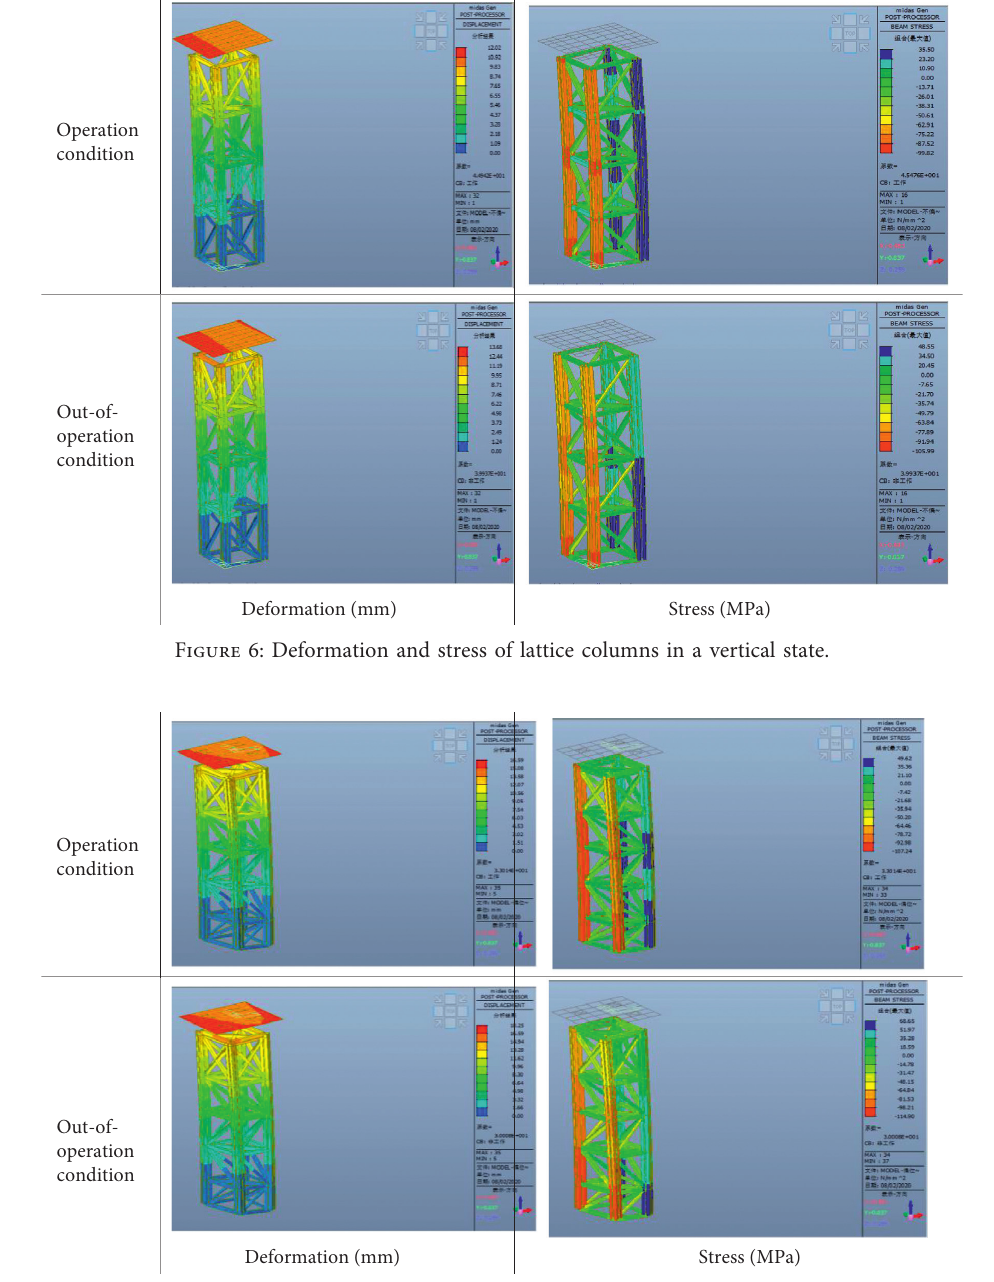
Figure 7: Deformation and stress of lattice columns in an inclined